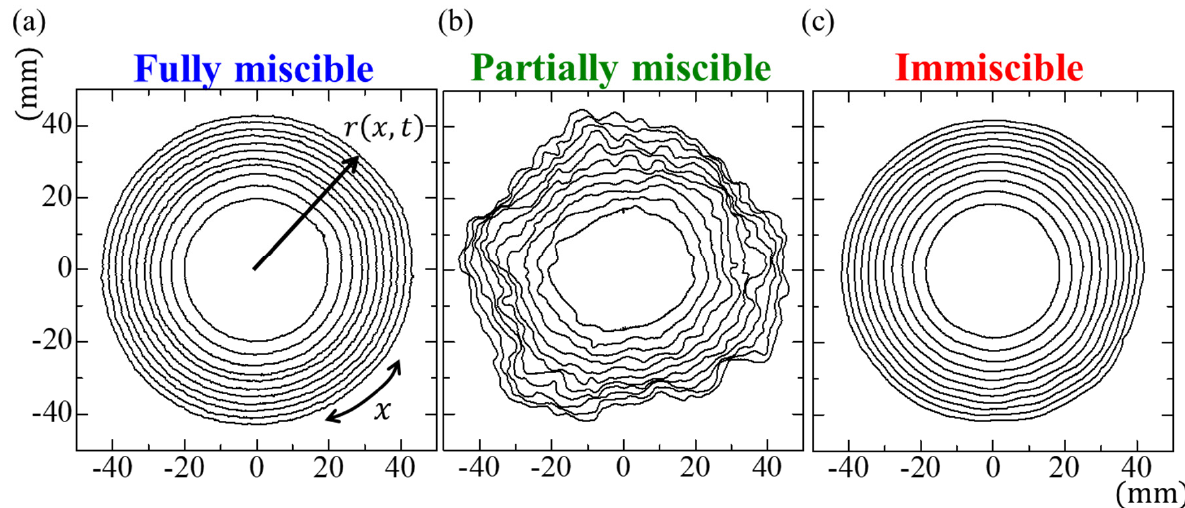
Figure 4. Time evolution of the interface for the ( a ) fully miscible, ( b ) partially miscible, and ( c ) immiscible systems. The result lines are shown every 200 s ranging from t = 500 − 2500 s.